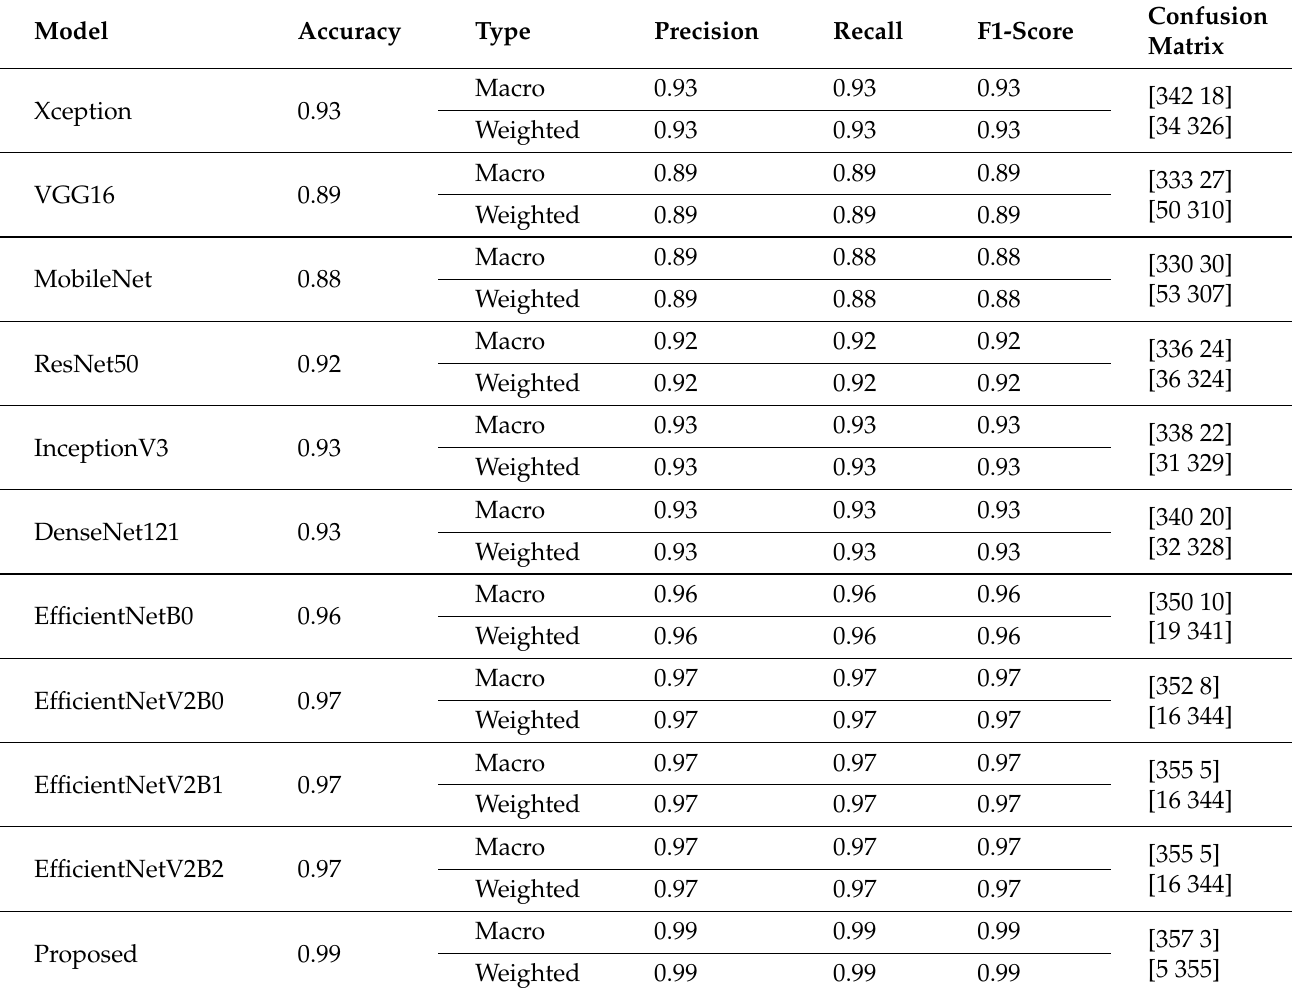
Table 4. Detailed results for skin disease